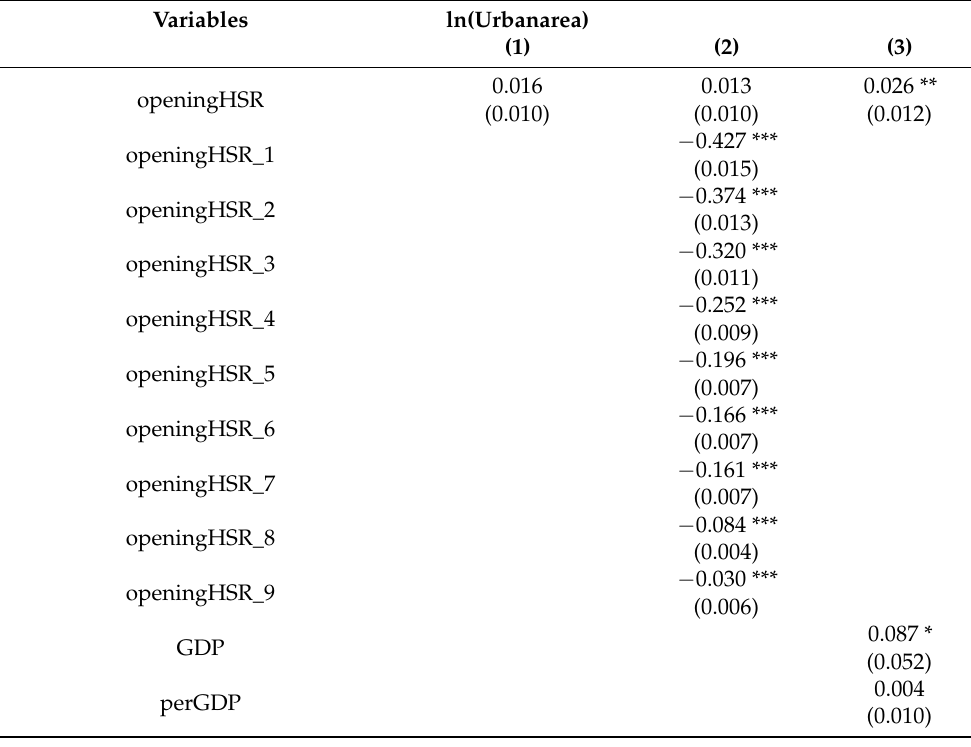
Table 2. The overall impact of HSR on urban expansion in